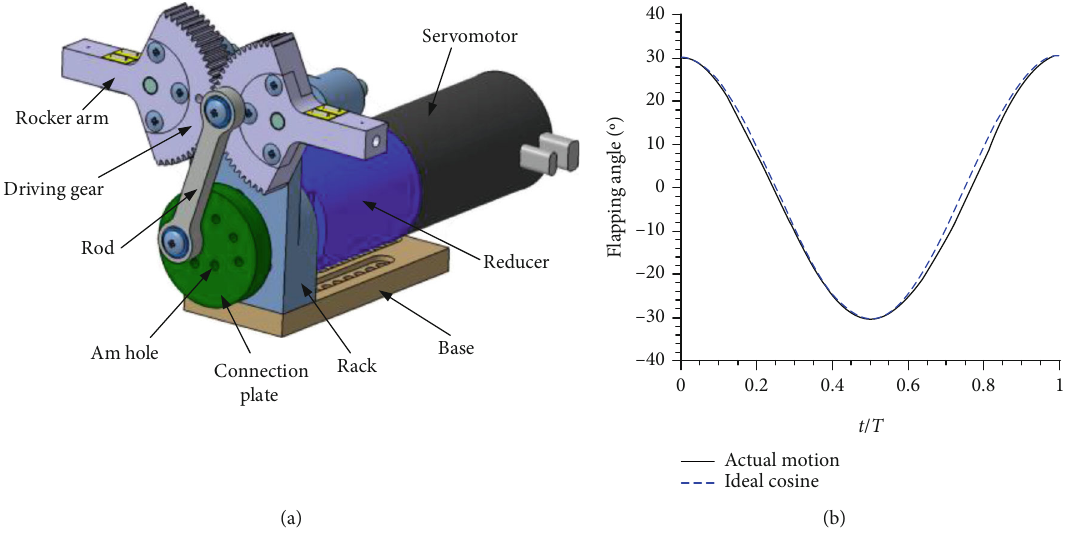
Figure 3: Flapping